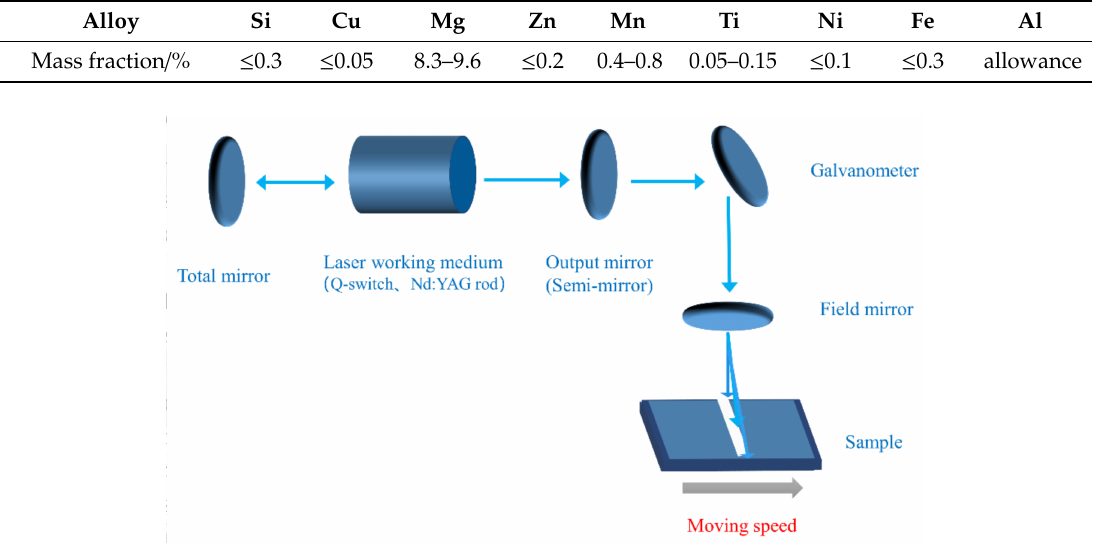
Figure 2. Schematic of laser cleaning